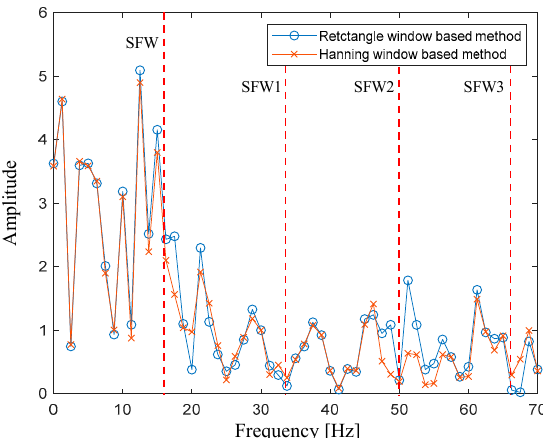
Figure 30. The IF curve of the displacement signal.